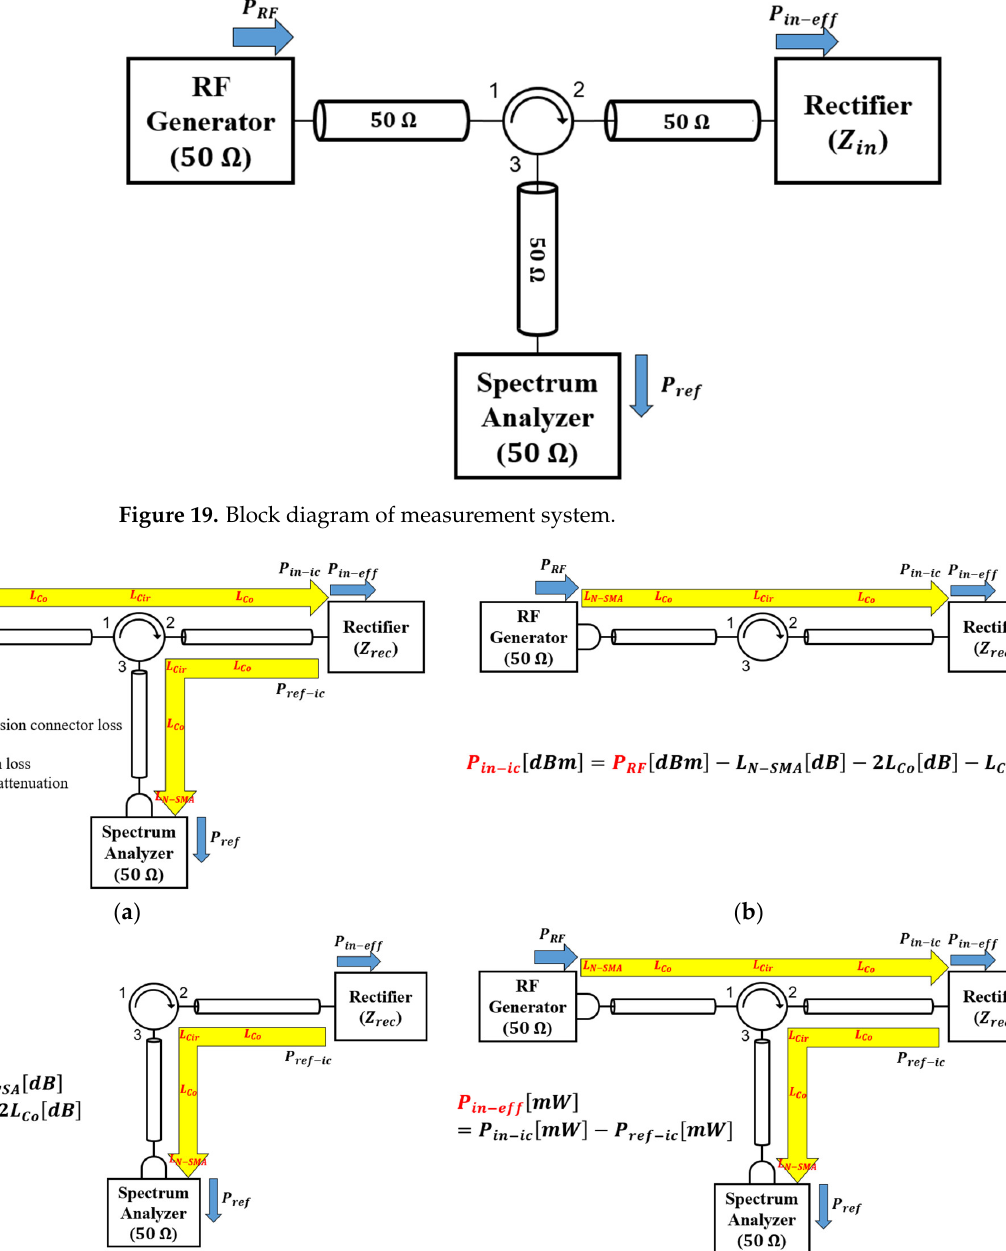
15 of 21 Figure 18. Input impedance of the evaluation board at the input frequency of 0.5~1.5  .